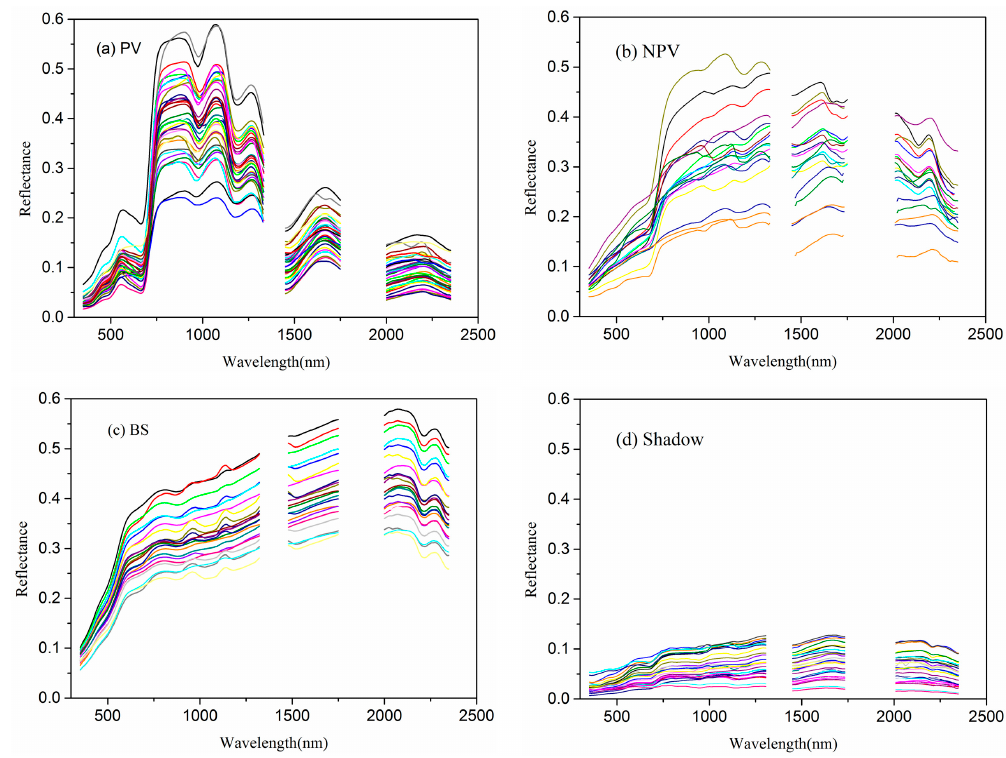
Figure 5. Spectral library of each endmember class. ( a ) PV; ( b ) NPV; ( c ) bare soil (BS); ( d ) shadow. Remote Sens. 2020 , 12 , x FOR PEER REVIEW